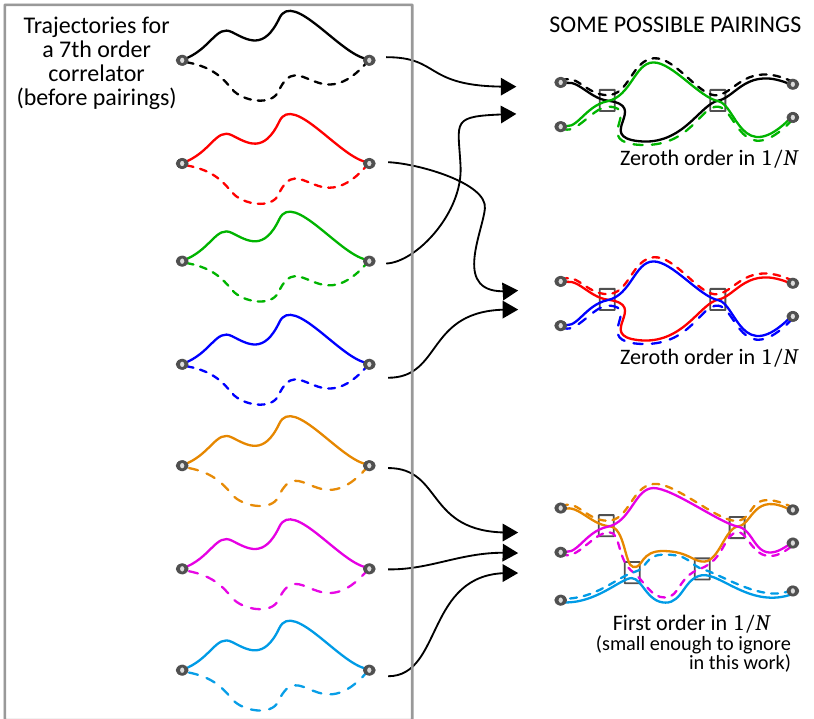
(cid:10) δ T ( ) δ T ( E ) ··· δ T ( E ) (cid:11) for M = 7. On the left, each E Figure 8: Contributions to M 1 2 δ T ( E ) is represented by two trajectories of the same colour joined at beginning and i end. Only contributions where the trajectories are connected contribute to the aver- age. On the right, we show one possible way of connecting them. All trajectories are in pairs, but they swap pairings at the encounters (black rectangles). If any colour is only two pairs of trajectories (such as black-green or red-blue here) are zeroth